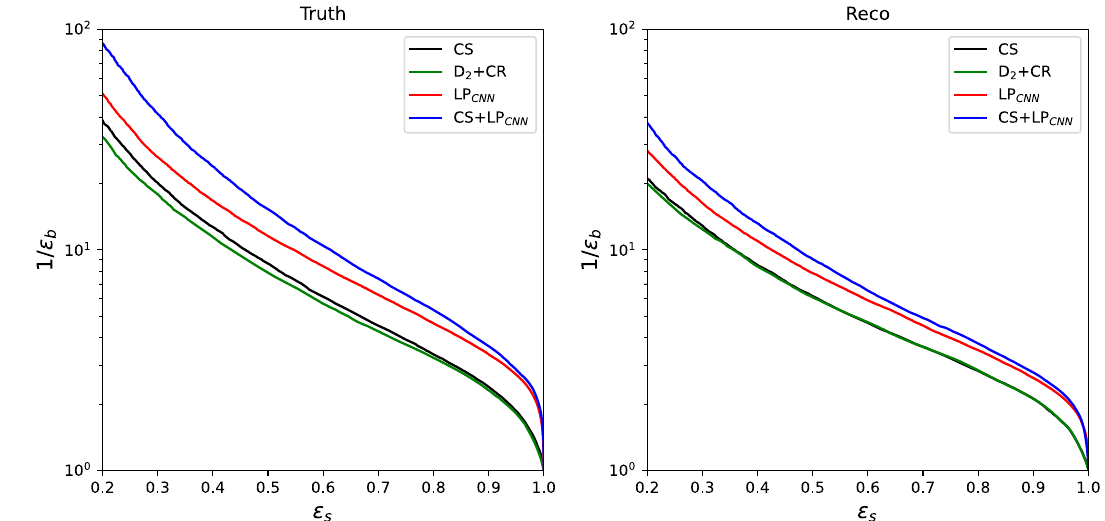
Fig. 4 The ROC curves showing background rejection as a function of signal efficiency for the truth (left) and reco case (right) for CS variables, LP CNN and the combined cases